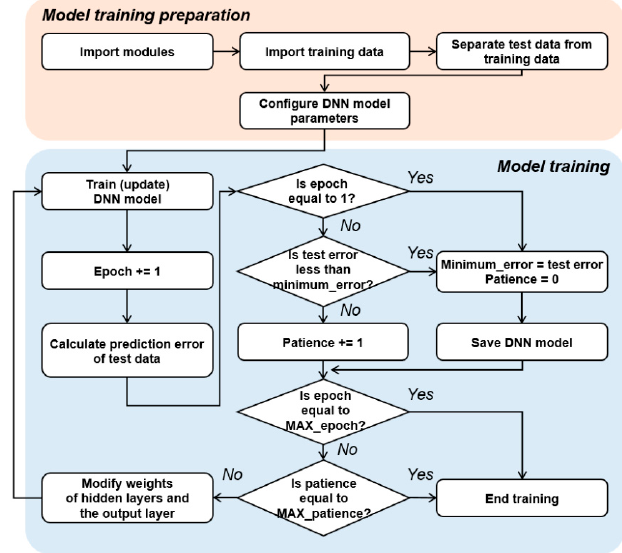
Figure 5. Flowchart illustrating procedures for DNN model training algorithm.